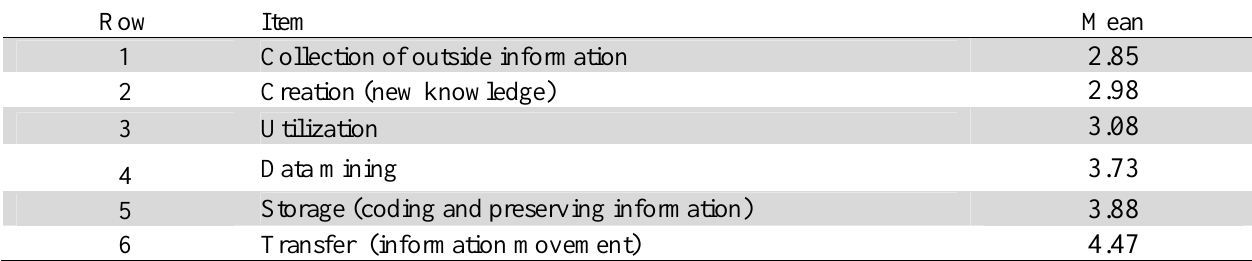
Comparing the average of the sub-systems of knowledge